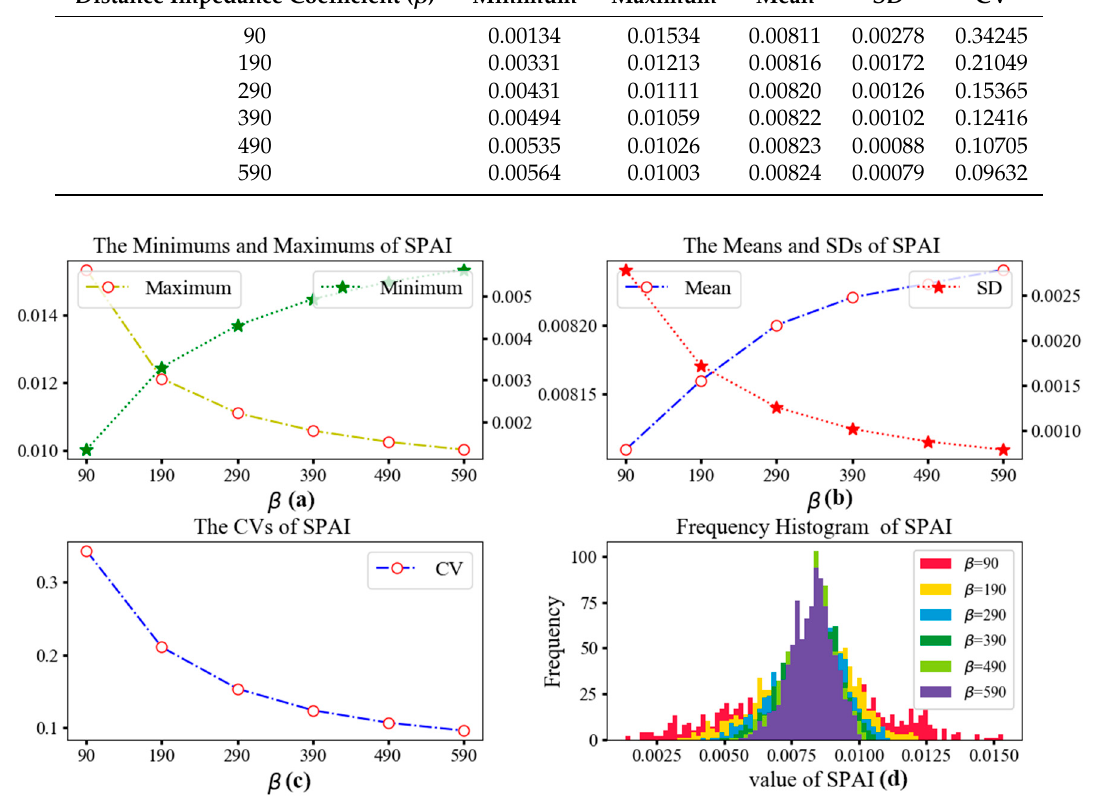
Figure 7. ( a ) The minimums and maximums of SPAI; ( b ) The means and SDs of SPAI; ( c ) The CVs of SPAI; ( d ) The frequency histogram of SPAI.